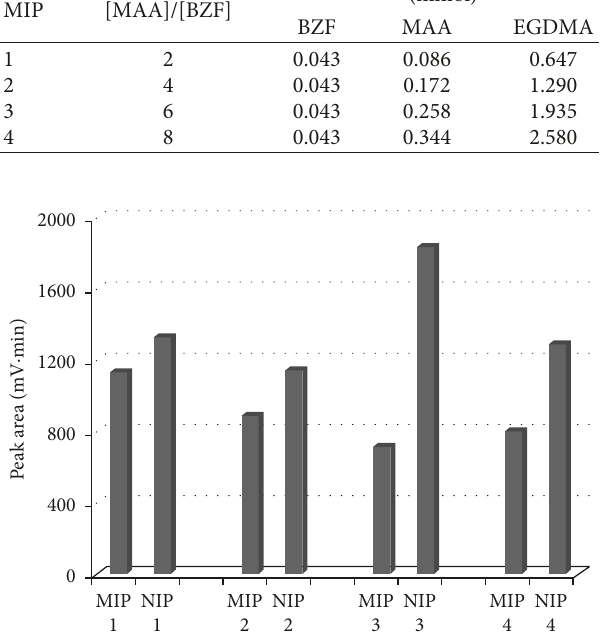
Figure 5: BZF peak area for each MIP/NIP after incubation